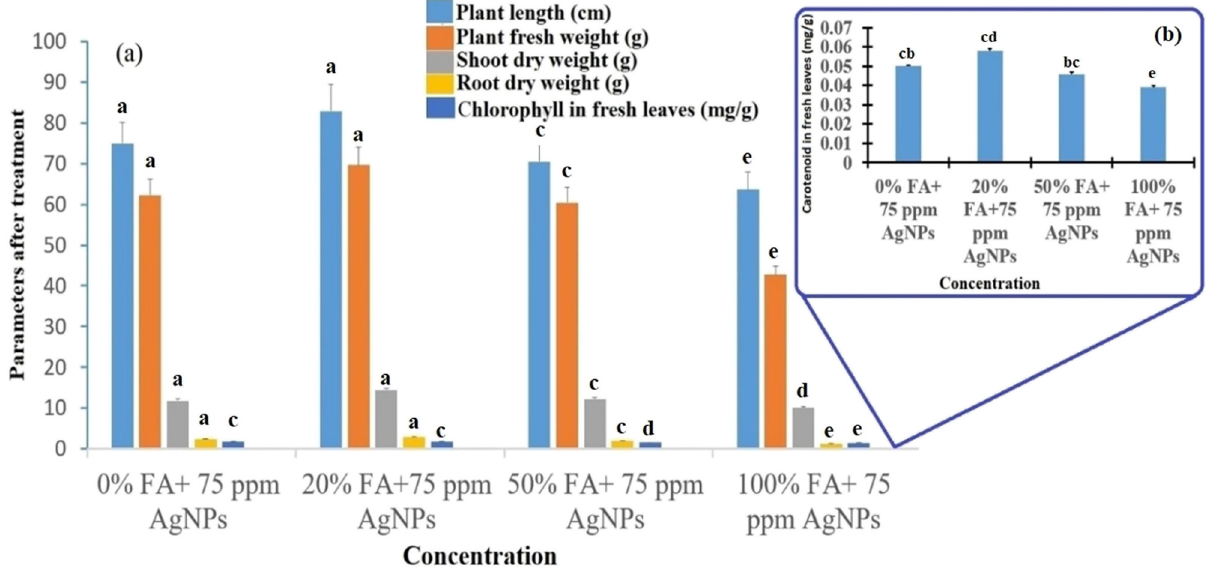
Figure 10: E ff ect of di ff erent concentrations of fl y ash with an e ff ective concentration of silver nanoparticles ( 75 ppm ) on the growth of the eggplant plant. 0% FA + 75 ppm AgNPs, 20% FA + 75 ppm AgNPs, 50% FA + 75 ppm AgNPs and 100% FA + 75 ppm AgNPs on the plant length ( cm ) , plant fresh weight ( g ) , shoot dry weight ( g ) , root dry weight ( g ) , chlorophyll in fresh leaves ( mg/g ) , and ( b ) carotenoid in fresh leaves ( mg/g ) . Graph ( b ) with fraction data is constructed separately because the graph is not visualized when combined with graph ( a ) with large data values. The mean and standard deviation values were used to create the bar graph ( Dunnett ’ s test was used as a post hoc test ) . Statistically signi fi cant level: p <